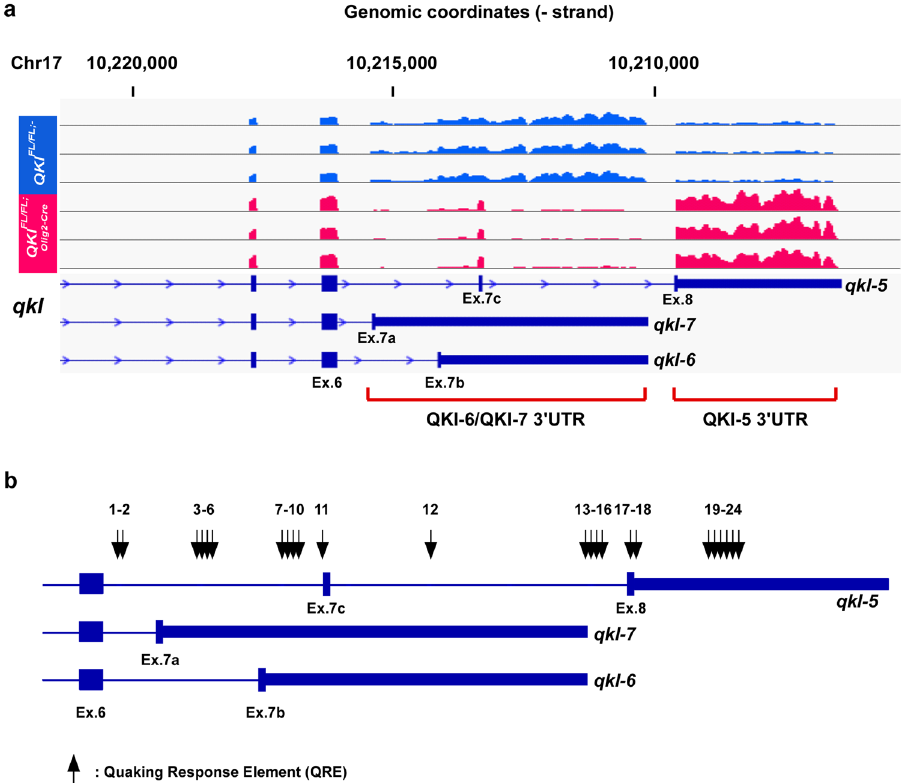
Figure 5. Alterative splicing patterns of qkI in QKI FL / FL ; Olig2 - Cre and QKI FL / FL ;- mice. ( a ) IGV view of the alternative splicing events in qkI . All samples are represented on the same scale for each screenshot. ( b ) A schematic of the 3 ′ -UTR of mouse qkI gene showing the location of Quaking Response Elements (QREs) identified. QREs are either a perfect match to consensus QRE or differ by one